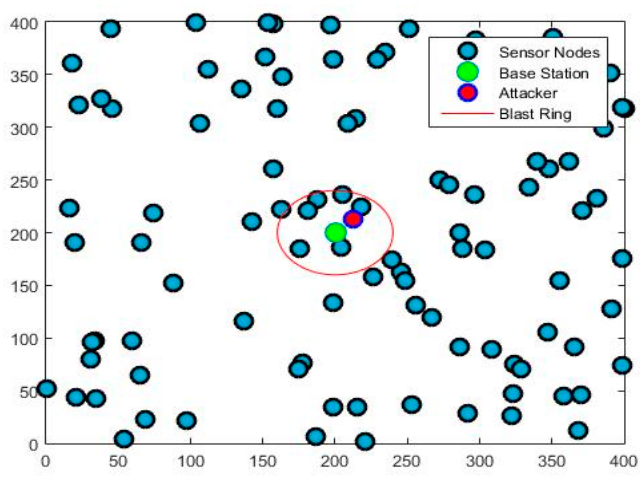
Figure 10. Our proposed simulation model.